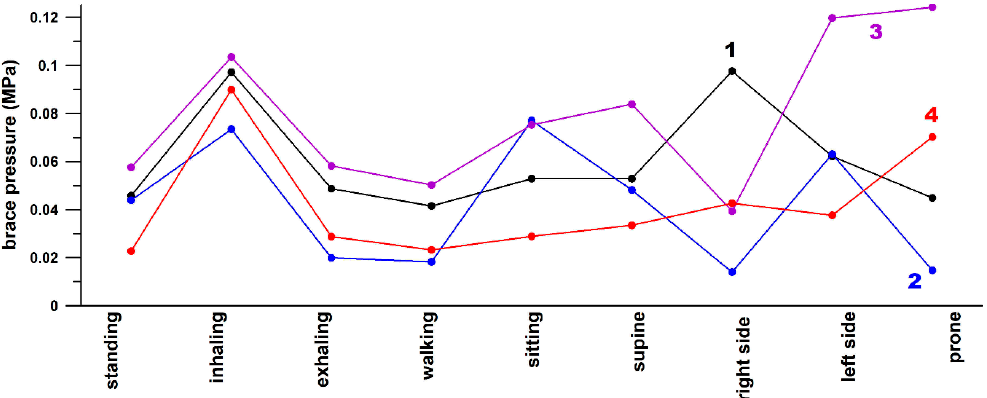
Figure 7. Average sensor pressure data recorded inside the brace at different body positions, and at different levels of the scoliosis curve (thoracic and thoracolumbar); 1: participant A, thoracic curve; 2: participant A, thoracolumbar curve; 3: participant B, thoracolumbar curve; 4: participant B, thoracic curve.